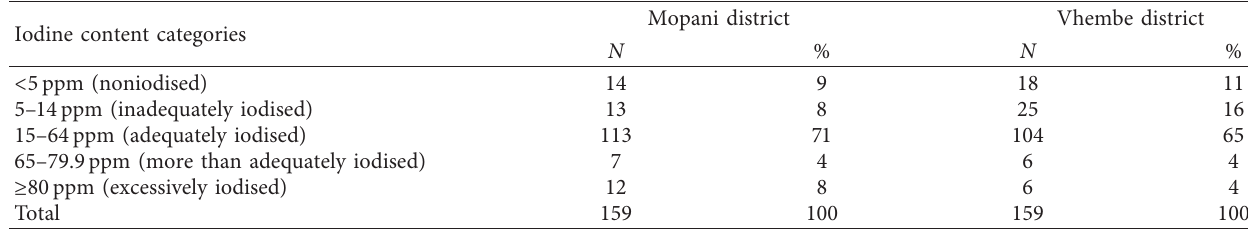
Table 3: Distribution of salt by iodine concentration.